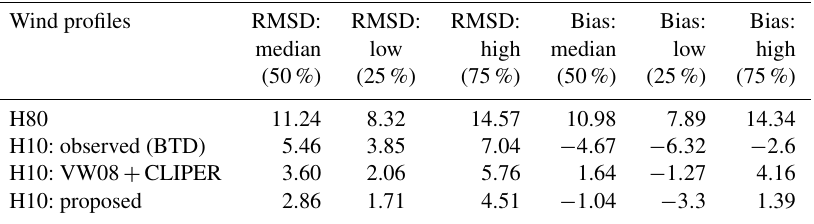
Table 5. Root-mean-square difference (RMSD) and bias (ms − 1 ) between modeled and measured azimuthally averaged wind speeds based on QSCAT-R data. The data analyzed in the table refer to all TCs with wind speeds between 40 and 5ms − 1 and a normalized radius between 3 and 16. Statistics are shown for median values (50%) and the IQR range (25%–75%). With “H10: observed” the authors refer to the Holland et al. (2010) wind profile in combination with the RMW and AR35 from the BTD. Wind